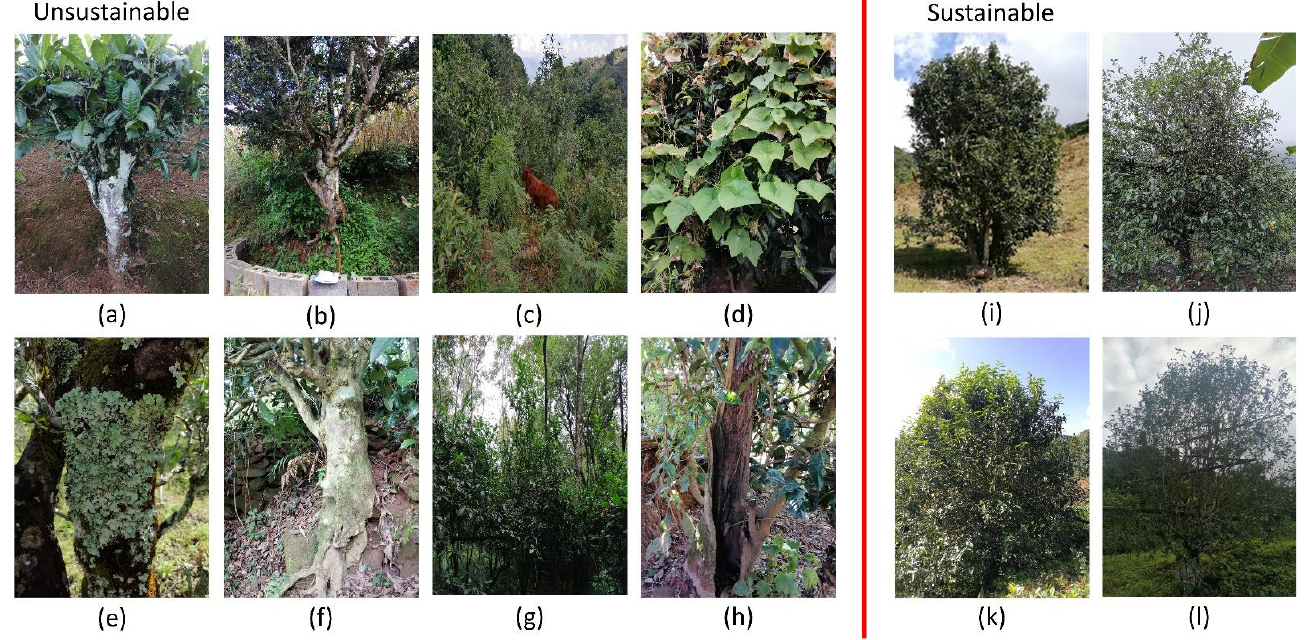
Figure 7. Variation in the management of ancient Pu’er tea trees. ( a – h ) are unsustainable (poorly managed); ( i – l ) are sustainable (well